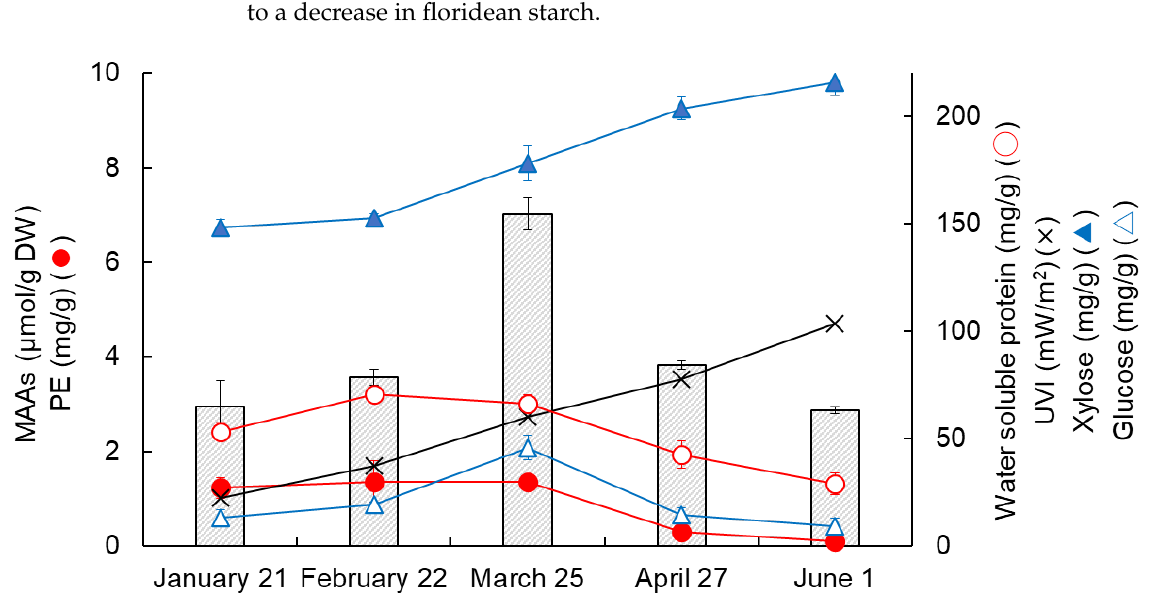
Figure 3. Monthly variations in MAAs, proteins, and saccharides in dulse collected in 2021. The amount of MAAs was expressed as total MAA content. Water-soluble protein was determined using the gravimetric method. The amount of PE from dry weight was determined using the Beer and Eshel equation [48]. Glucose and xylose were determined via colorimetric methods. Erythemal UV intensity was obtained from the Japan Meteorological Agency (https://www.data.jma.go.jp/gmd/env/uvhp/info_uv.html, accessed on 27 December 2021).